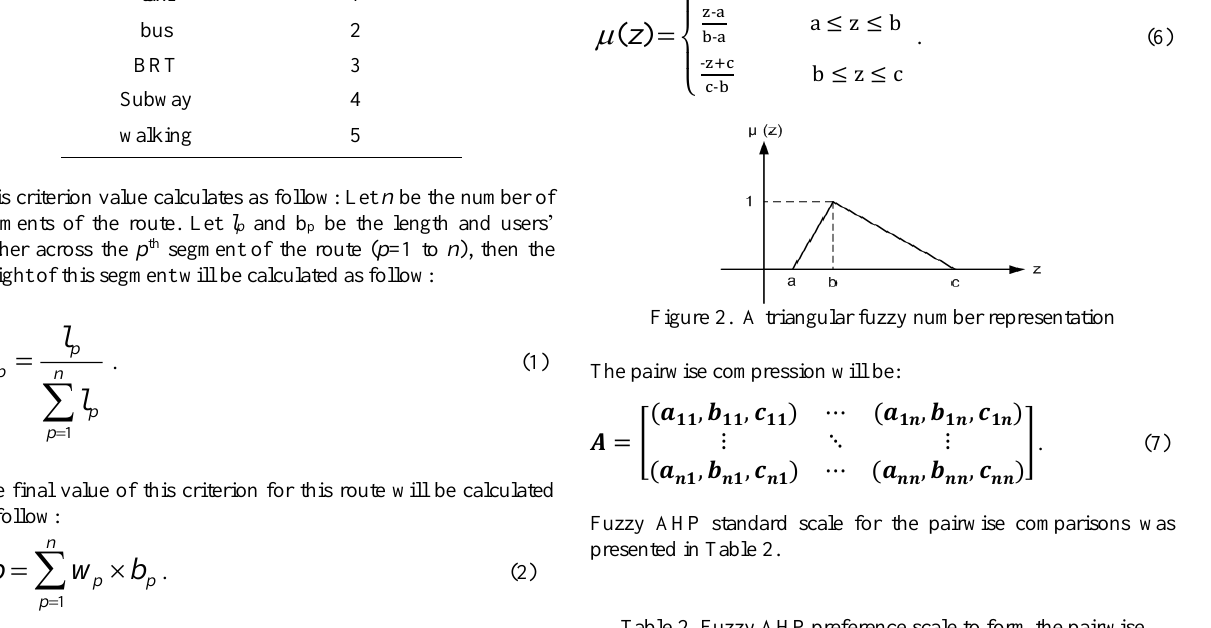
Table 2. Fuzzy AHP preference scale to form the